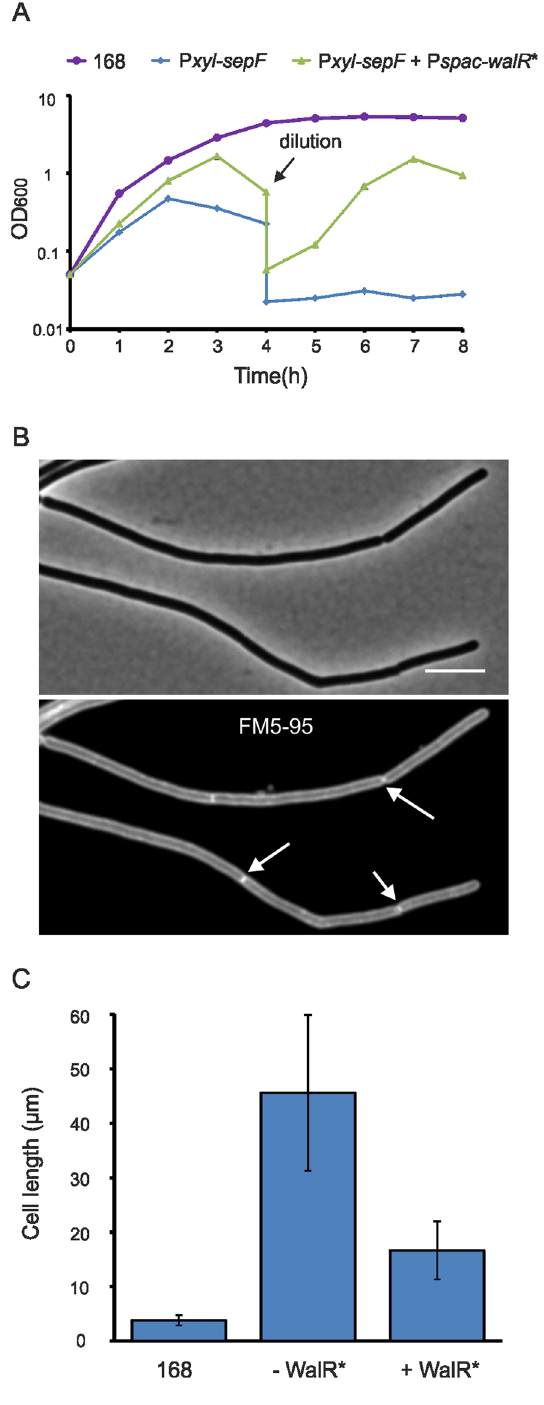
Figure 6. Expression of constitutively activate WalR-R204C. ( A ) Growth of strain 168, GYQ215 ( amyE:: P xyl- sepF ) and strain GYQ159 ( amyE:: P xyl-sepF aprE:: P spac-walR-R204C ) in medium with 1% xylose to induce SepF. In case of strain GYQ159, 1 mM IPTG was added to induce the constitutively active WalR variant R204C ( walR * ). After 4 h, the culture was diluted. ( B ) Microscopy images of GYQ159 at t = 6 h. Septa are indicated by arrows. Cells were stained with the membrane dye FM5-95. Scale bar is 5 µ m. ( C ) Cell length measurement of 168, GYQ215 ( − WalR * ) and GYQ159 ( + WalR * ). Samples were taken at t = 3